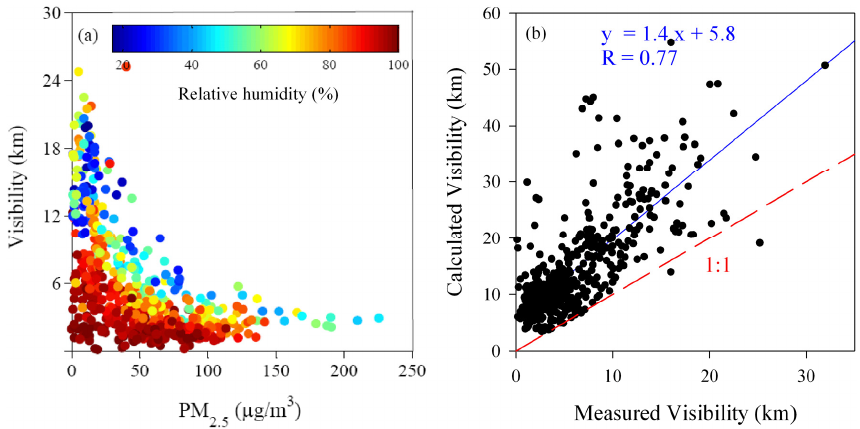
Fig. 7. (a) Scatter plot between hourly visibility and PM 2.5 concentration grouped by the corresponding relatively humidity (b) linear relationship between the measured and calculated visibility, the regression equation and 1:1 line are also shown in the figure.